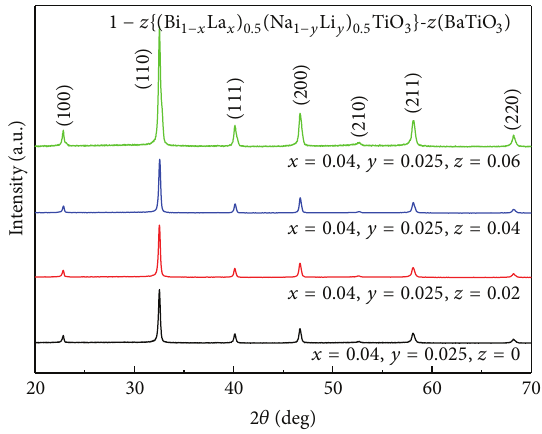
Figure 1: XRD patterns of [ 1 − 𝑧 (BLNLT)- 𝑧 (BT), 𝑥/𝑦/𝑧 = 0.04/0.025/0, 0.02, 0.04, 0.06] system.